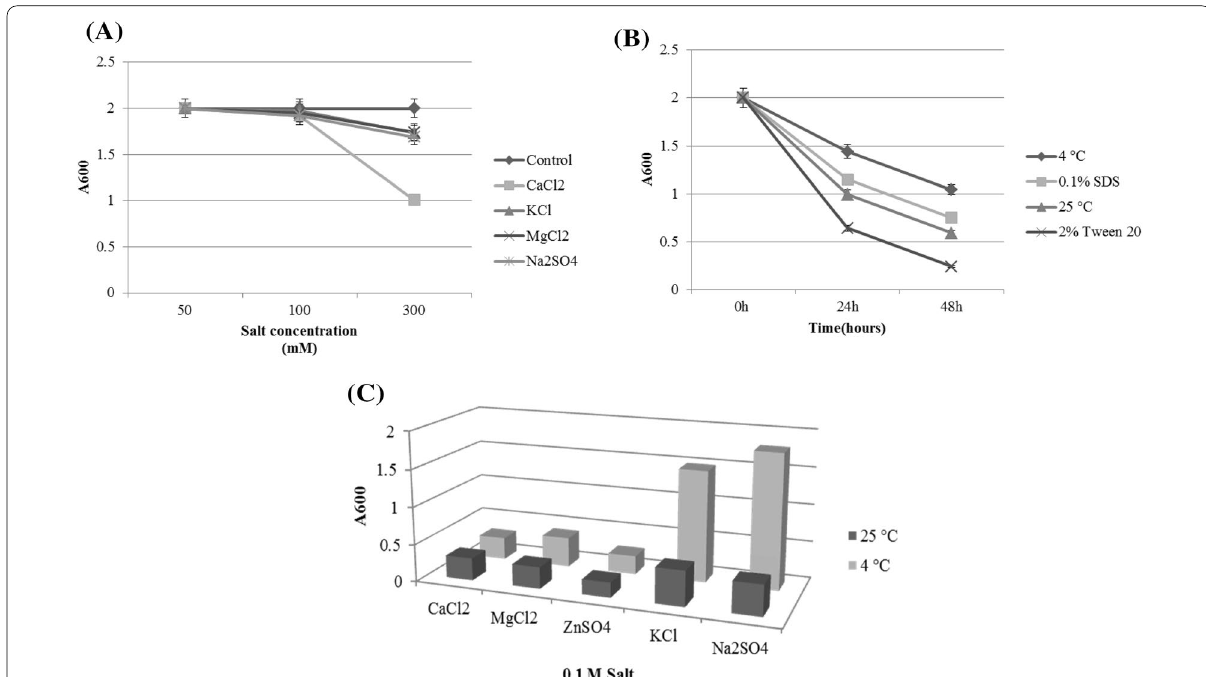
Fig. 4 Turbidity tests of AOBs at 600 nm. The measurements were conducted at room temperature and pH 7.5 unless mentioned. The constituted oil bodies were exposed to A salt concentrations (50–300 mM) for 15 min, B temperature and surfactants for 24 h and C 0.1 M monovalent (NaCl and KCl) and divalent (MgCl 2 , CaCl 2 , and ZnSO 4 ) salts for 24 h at 4 °C and 25 °C